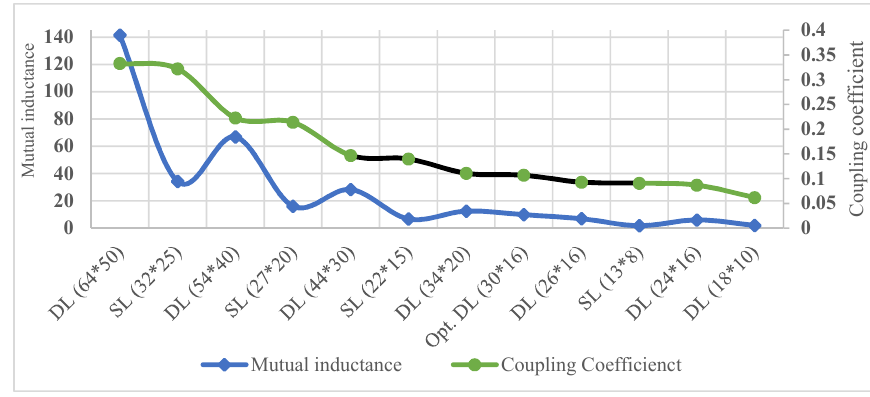
Figure 5. Mutual inductance and coupling coefficient of different winding methods.